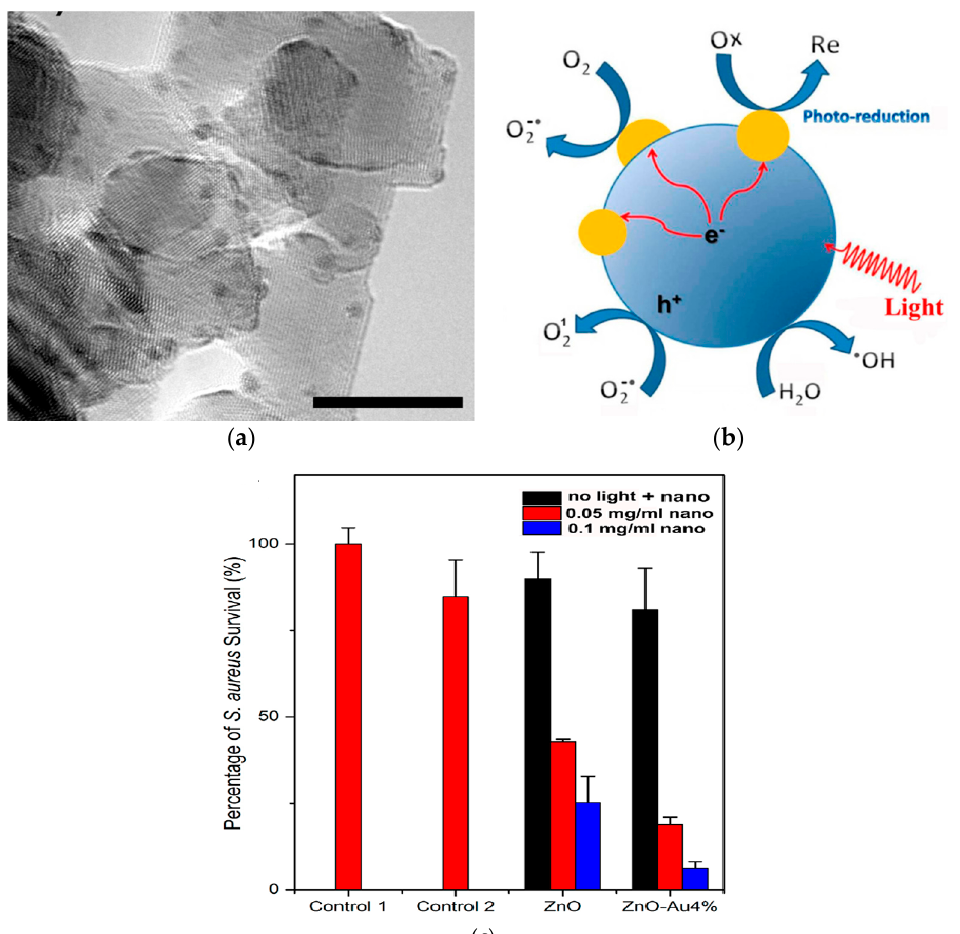
Figure 37. ( a ) TEM image and ( b ) schematic illustration of the production of hydroxyl, superoxide anion and singlet oxygen radicals on 4% AuNPs / ZnO exposed to simulated sunlight. Fine grey circles in ( a ) are AuNPs; scale bar is 20 nm. ( c ) A bar graph showing staphylococcus aureus survival upon exposure to ZnO NPs and 4% AuNPs / AgNPs at doses of 0.05 and 0.1 mg / mL without (black column) and with simulated sunlight illumination for 10 min. Control 1 is bacteria exposed to neither NPs nor light. Control 2 denotes bacteria exposed to simulated sunlight for 10 min in the absence of NPs. All tests are conducted in triplicates and repeated at least twice to obtain reproducibility. Reproduced from [305] with permission of the American Chemical Society.